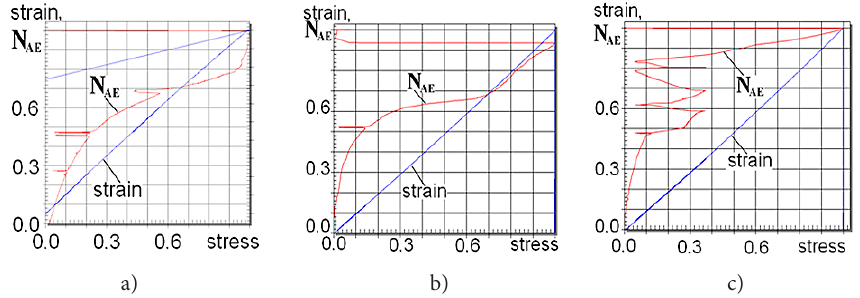
Figure 6. The dependence of the total acoustic emission and deformation on the stress of the sample with a longitudinal arrangement of fibres: a – with triple training 20% of the breaking load (sample width 20 mm); b – with a six-time training 15% of the breaking load (sample width 30 mm); c – with triple training 38% of the breaking load (sample width 30 mm)